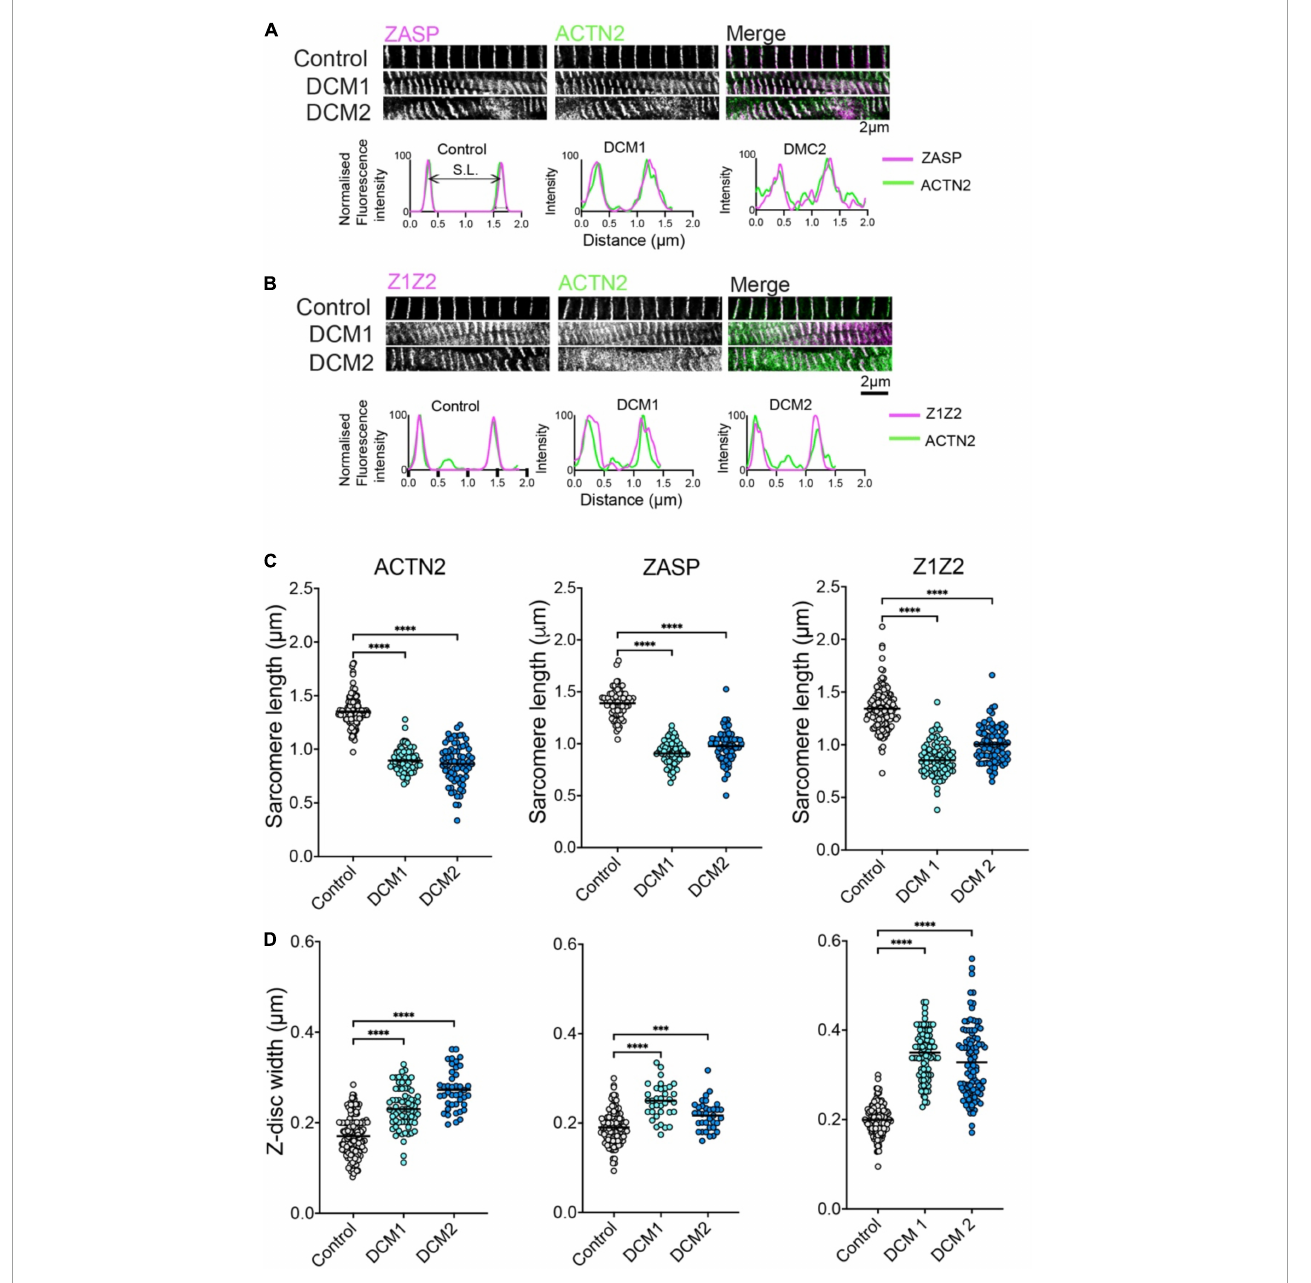
FIGURE2 ZASP, ACTN2 and titin Z1Z2 Z-disc labelling using Affimer combinations and analysis. (A) Example 2D-STED images of heart tissue sections from control (donor tissue) and two independent DCM patients with the same TTN mutation, co-stained using an Affimer to ZASP (magenta in merged image) and ACTN2 (green in merged image). Example line profiles for ZASP and ACTN2 across two a single sarcomere, including both Z-discs at either side are shown below. These profiles were used to estimate Z-disc width and sarcomere length. (B) Example images of heart tissue sections from control and DCM patients stained using an Affimer to titin Z1Z2 (Magenta in merged image) and ACTN2 (green in merged image). Example line profile plots are shown below. (C) Measurements of Z-disc width for control and DCM patients. (D) Measurements of sarcomere lengths for control and DCM